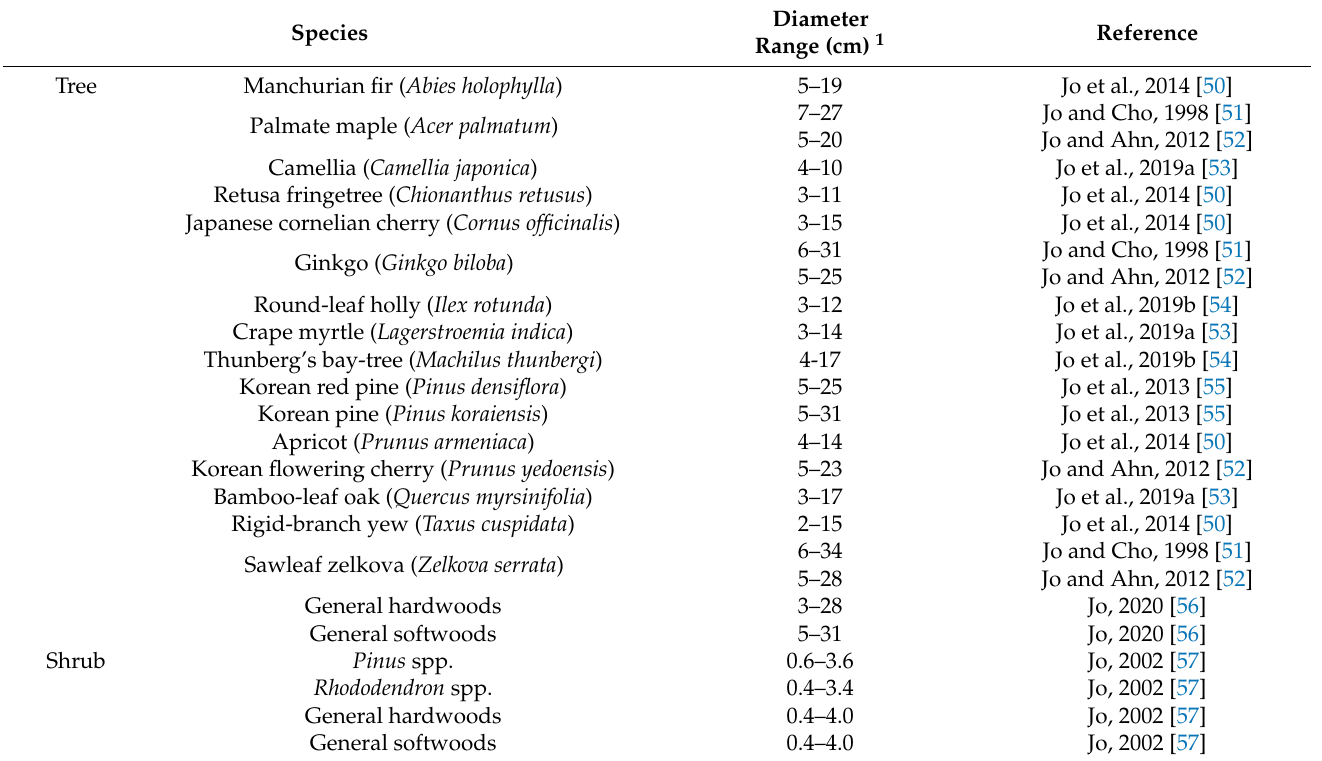
Table 2. Regression equation sources of tree and shrub species used to calculate carbon uptake and storage in the study